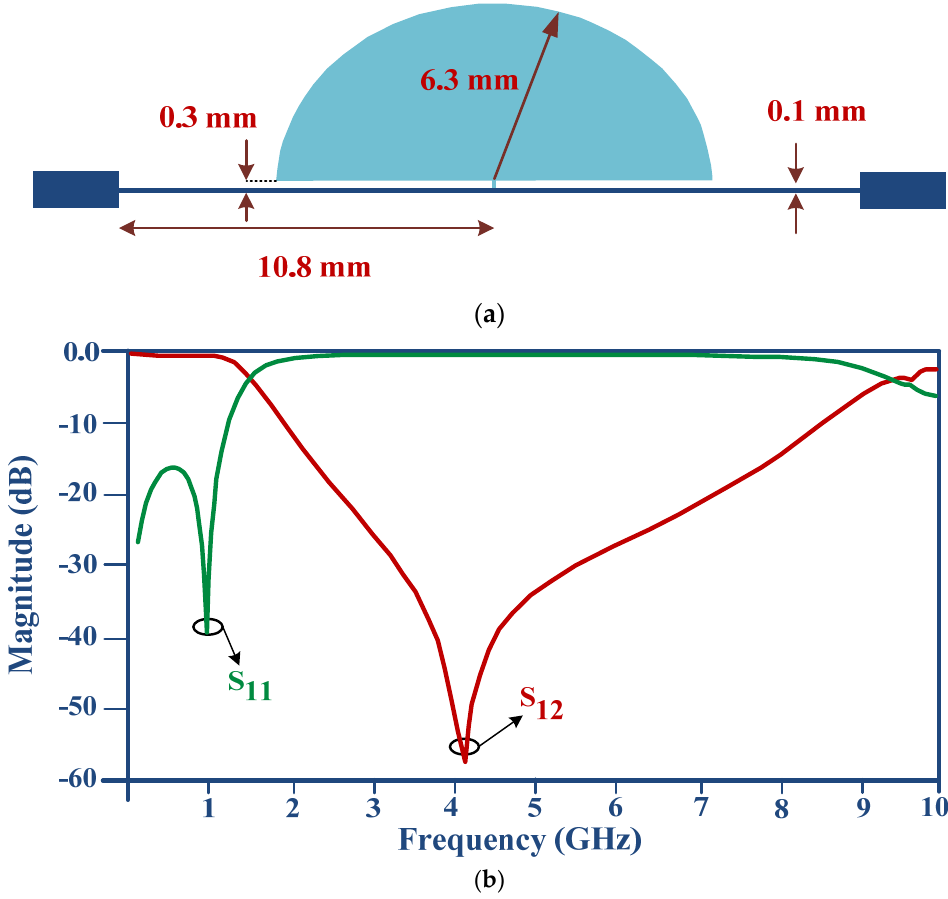
Figure 7. The modified half-elliptical shaped resonator ( a ) structure and ( b ) its frequency response.